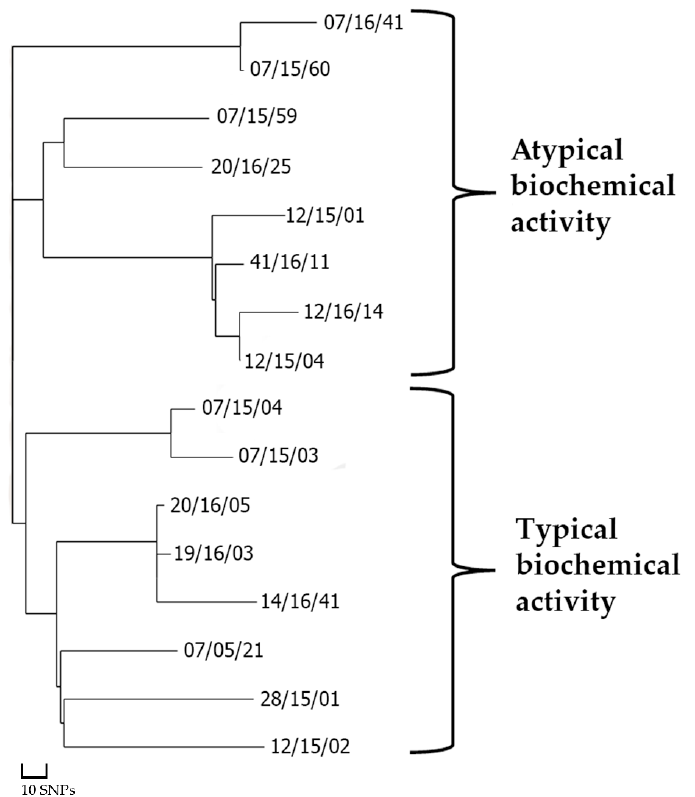
Figure 1. Clustering of Russian strains of N. gonorrhoeae G807 NG-MAST GENOGROUP/ST1594 MLST based on core single nucleotide substitutions.